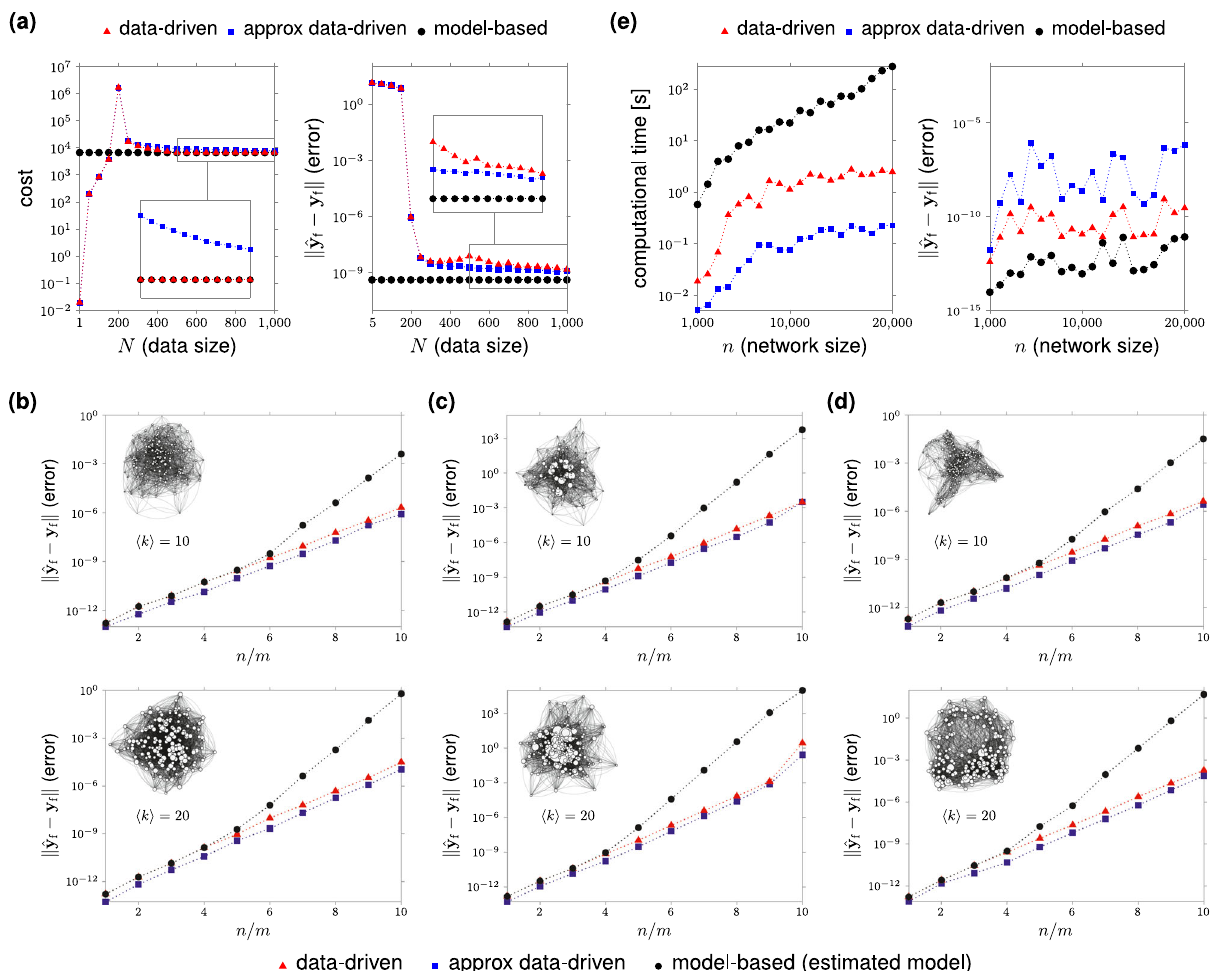
Fig. 3 Performance of minimum-energy data-driven network controls. Panel ( a ) shows the value of the cost function (left) and the (norm of the) error in the fi nal state (right) for the minimum-energy data-driven controls (5) and (6), and the model-based one as a function of the data size N . We consider Erdös – Rényi networks as in Fig. 2b with ε = 0.05, and parameters n = 1000, T = 10, m = 50, p = 200. In panels ( b – d ), we assume C = I and compare the error in the fi nal state generated by the data-driven minimum-energy controls (5) and (6) and model-based expression for a fi xed number of control nodes m = 100 and increasing dimension n ∈ [100, 1000]. The model-based control has been computed by fi rst estimating matrices A and B from data according to the subspace-based technique in “ Methods ” , and then using the model-based control expression. In panel ( b ), we consider Erdös – Rényi networks with average degree 〈 k 〉 = 10 (top) and 〈 k 〉 = 20 (bottom). In panel ( c ), we consider Barabasi – Albert networks 71 with the initial number of nodes m 0 = 20 and average degree 〈 k 〉 = 10 (top) and 〈 k 〉 = 20 (bottom). In panel ( d ), we consider Watts – Strogatz networks 72 with rewiring probability p rew = 0.2 and average degree 〈 k 〉 = 10 (top) and 〈 k 〉 = 20 (bottom). In all plots, we use a control horizon T = 15 and a number of the data N = mT + 200. To limit the in fl uence of eigenvalues in the computation of optimal controls across different network models, we normalize matrix A by its norm ∥ A ∥ . The curves represent the average of over 100 realizations of networks, data, control nodes, and fi nal states. Panel ( e ), left, compares the time needed to compute the optimal controls via data-driven and model-based strategies as a function of the network size, for one realization of the Erdös – Rényi model of Fig. 2b and data. Panel ( e ), right, shows the errors in the fi nal state. We use the following parameters: ε = 0.05, m = ⌊ n /100 ⌋ , p = ⌊ n /50 ⌋ , T = 50, and N = mT + 100. For additional details, see “ Methods ”